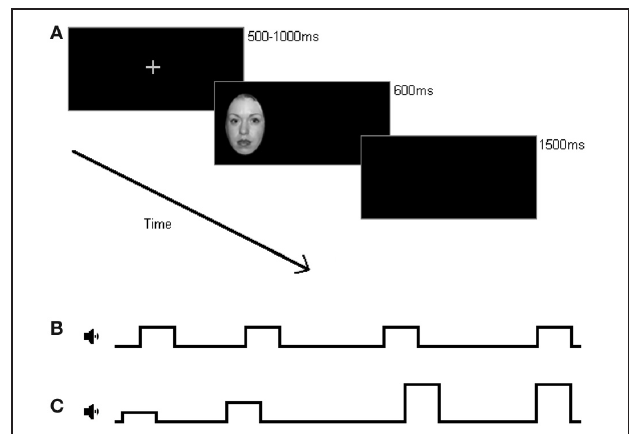
FIGURE 1 | Example trial display (not to scale). (A) Following fixation, a face image appeared either in the left or right periphery, displaying either a neutral, angry, or happy emotional expression. Depending on the block type, participants were asked to move their eyes from fixation to the image as quickly as possible, or look away from the image and move their eyes to the opposite end of the screen. (B) In addition to eye movements, participants simultaneously responded verbally to tones played during blocks. Under low load, participants always heard a mid-pitched tone, and responded by saying “tone” each time they heard a sound. (C) Under high load, tones were presented at three different pitches, and participants responded to this with “low,” “mid,” or “high” when a tone played. All tones played randomly every 1900–2300